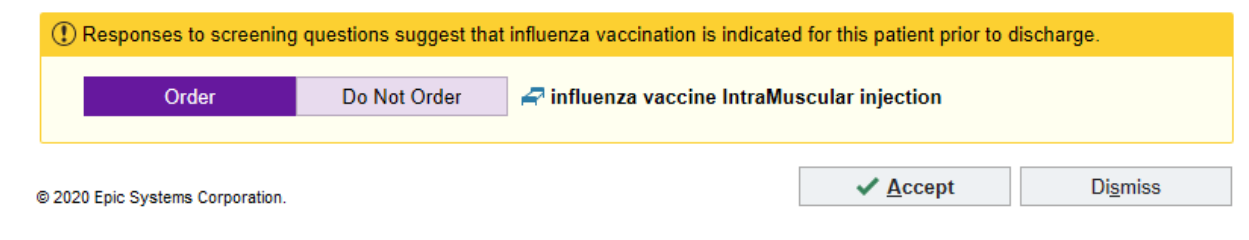
Figure 2. Original version of the flu alert tested in the randomized controlled trial (RCT). Copyright 2020, Epic Systems